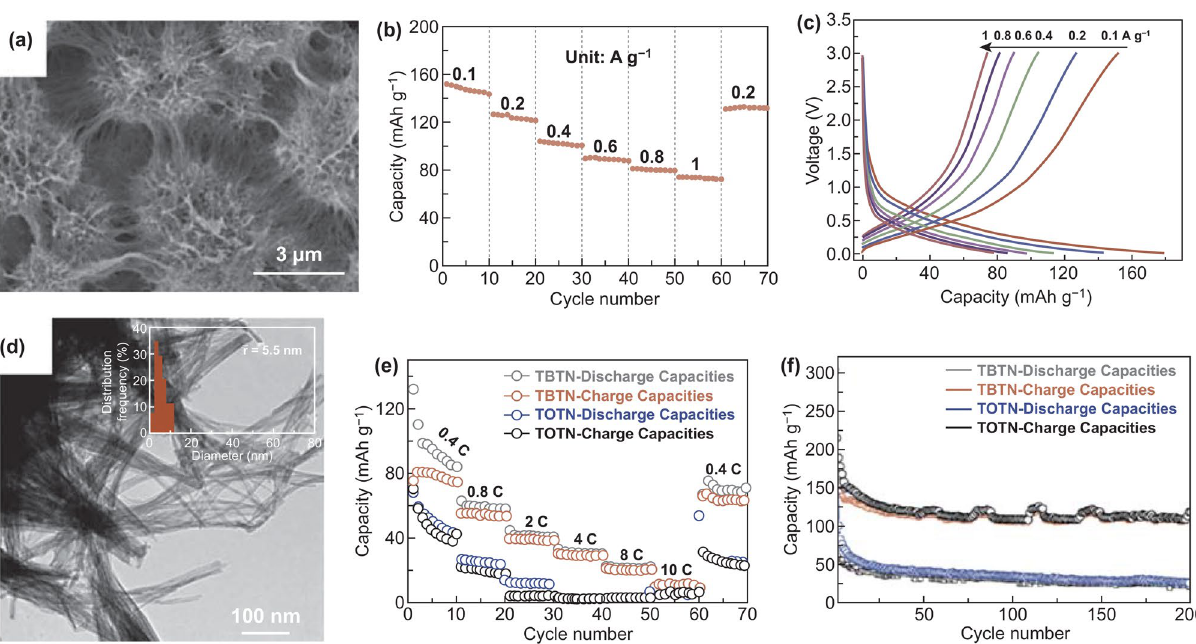
Fig. 13 a T-Nb 2 O 5 ’s SEM image. b T-Nb 2 O 5 anode’s rate performance in the range of 0.1–1 A g −1 . c Corresponding charge capacities under various current densities. Reproduced with permission from Ref. [228]. Copyright 2018, Royal Society of Chemistry. d TEM image of TBTN with average diameter of around 5.5 nm. e Rate performance and f cycle performance of TBTN. Reproduced with permission from Ref. [71]. Copyright 2018, John Wiley and